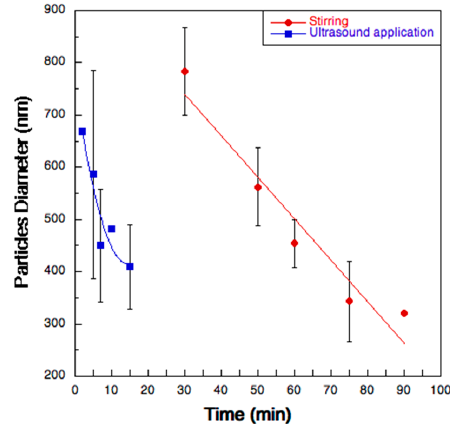
Figure 5. Diameter variation as a function of time of the microparticles suspended in two different test conditions: magnetic stirring (red circles) and ultrasound application (blue squares). conditions: magnetic stirring (red circles) and ultrasound application (blue